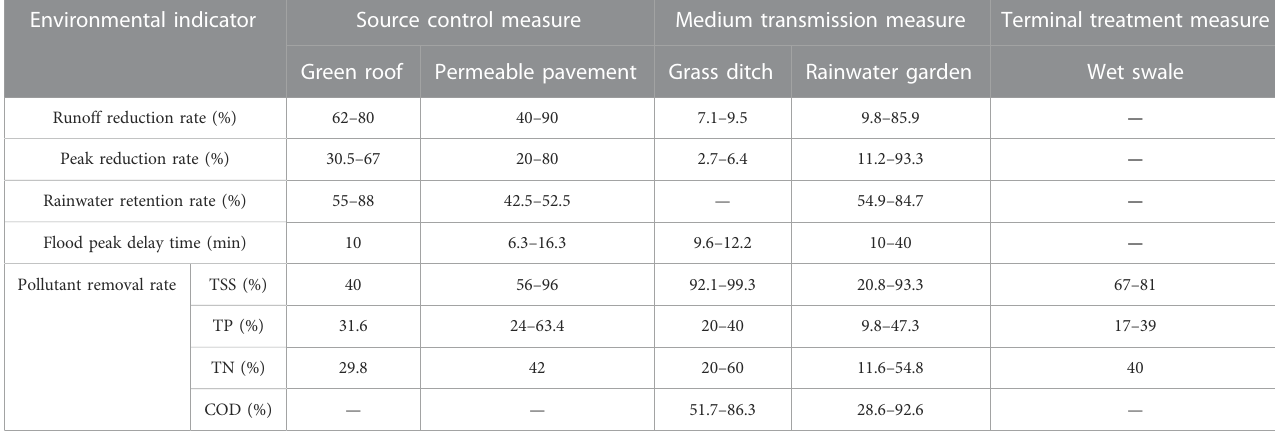
TABLE 3 Comparison of ecological bene fi ts of urban rainwater utilization measures. Environmental indicator